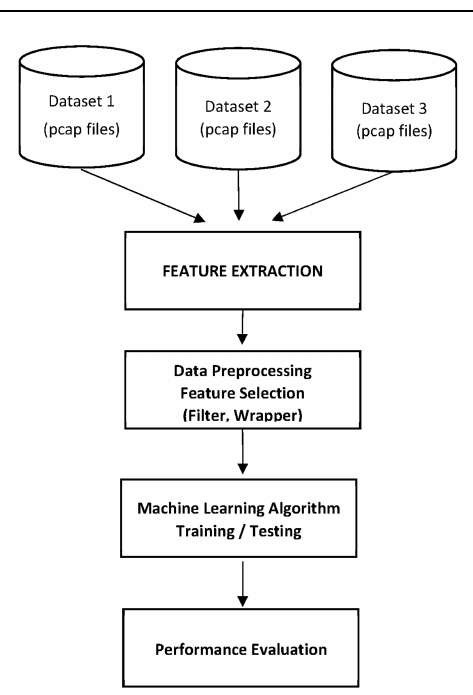
Figure 1. System architecture